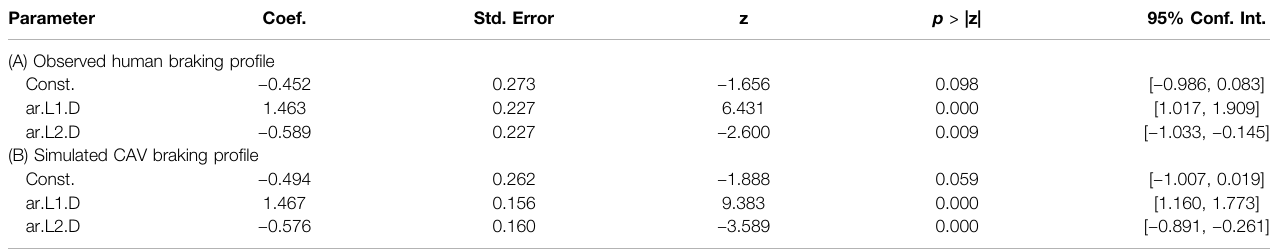
TABLE 5 | ARIMA model results for (A) human, and (B) simulated CAV braking pro fi les under free-following driving condition. Parameter Coef.